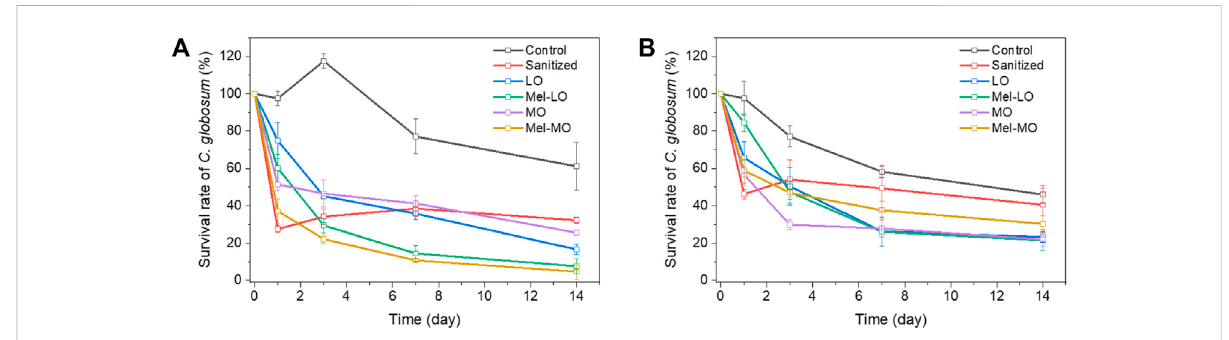
FIGURE 6 Survival rate (%) of C. globosum over time on (A) radial-longitudinal and (B) tangential-longitudinal wood samples.